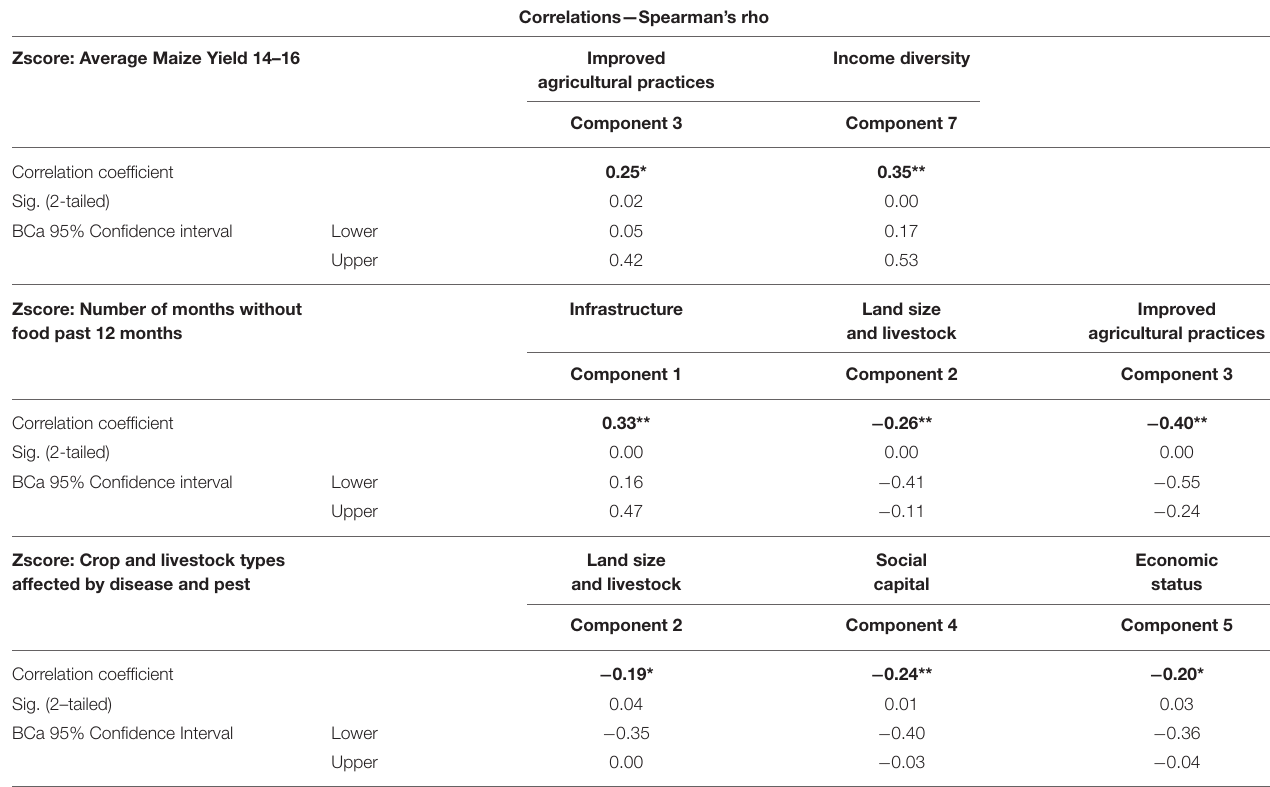
TABLE 4 | Significant correlations between BC components and maize yield, pest/disease incidence and food insecurity (see Table 7 in Supplementary Material 4 for overview of all correlation coefficients). Correlations—Spearman’s rho Zscore: Average Maize Yield